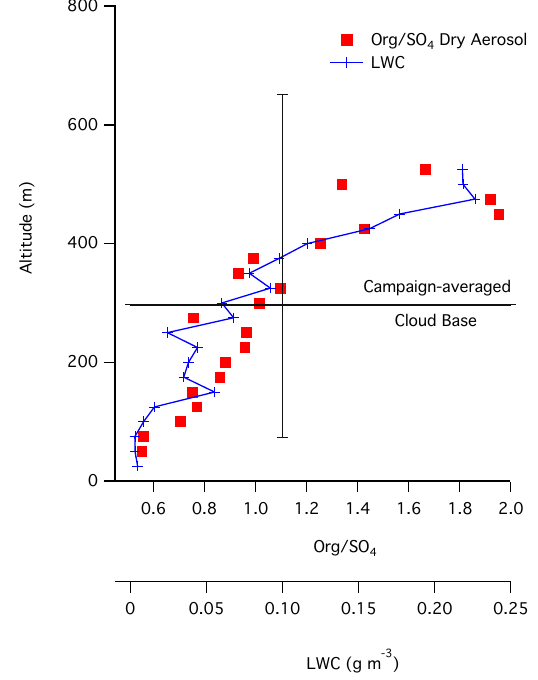
Fig. 3. Marine aerosol number size distributions of below-cloud aerosol measured during clean and perturbed flights (top and mid- dle panels). Aerosol size distributions for the exhaust of three ships (bottom panel). Lines are log-normal fits.